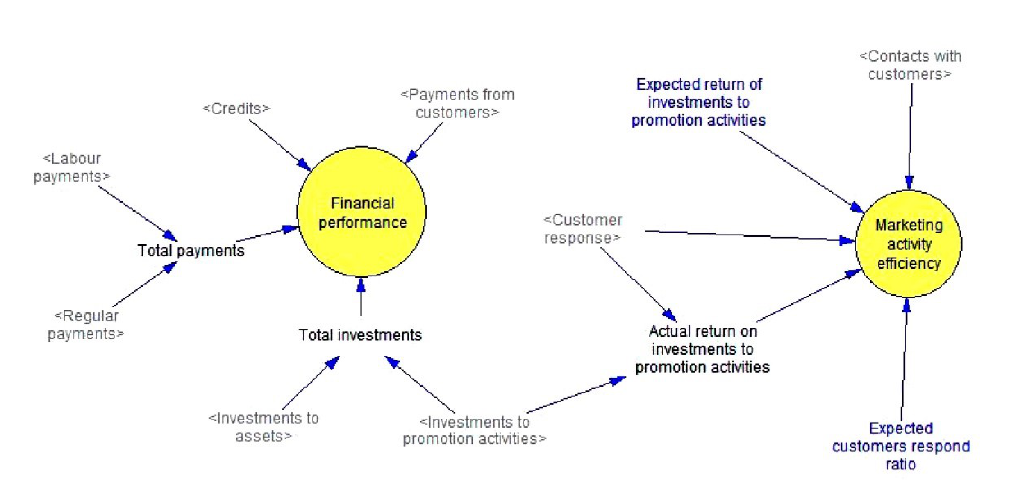
Fig. 9. Measurement of financial and marketing efficiency in 3PL (developed by the author).